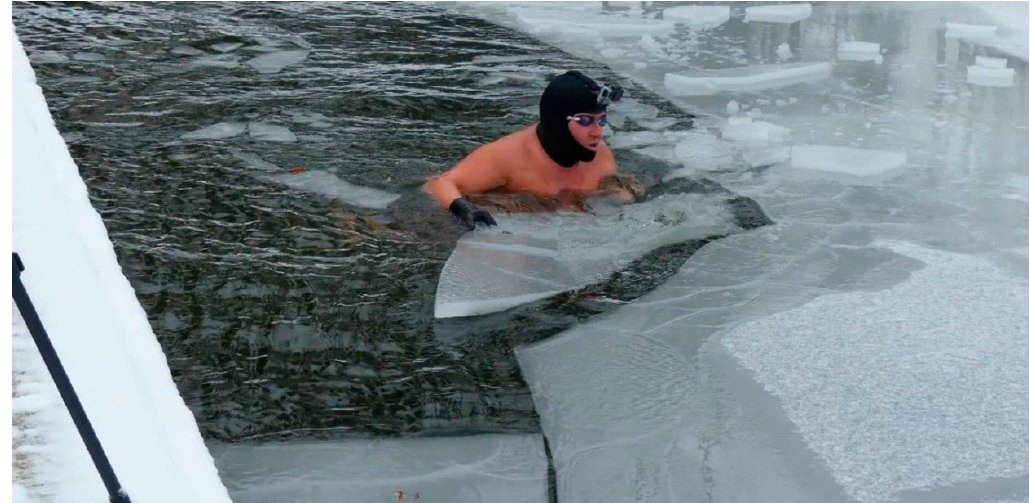
Figure 1. Ice swimmer in the preparation of his pool for training (Picture with permission of the athlete).